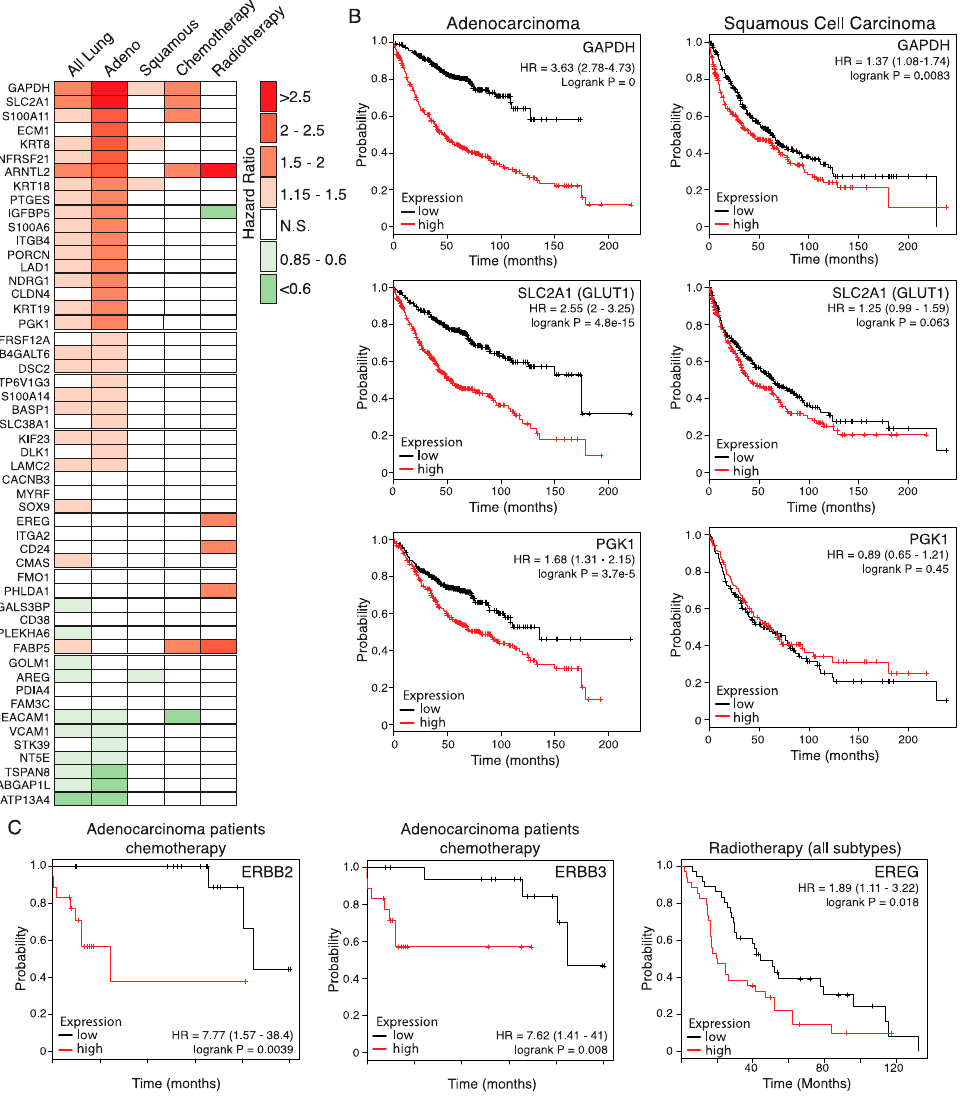
Figure 3. Relevance of the KM tumour progression signature for overall survival of human LuAd patients. ( A ) Hazard ratios (HRs) of lung cancer patient overall survival associated with high expression of genes listed in Table 1, determined on the basis of above-versus-below median gene expression, using included ( N = 1926), those with denocarcinoma (Adeno; N = 866), squamous cell carcinoma (Squamous; N = 675), and patients who received either chemotherapy ( N = 178) or radiotherapy ( N = 73). N.S. = Not statistically significant. ( B ) Overall survival plots based on above (red lines) versus below (black lines) median expression of glycolysis pathway genes in human lung adenocarcinoma (left panels) compared with lung squamous cell carcinoma (right panels). HR = hazard ratio. 95% confidence intervals